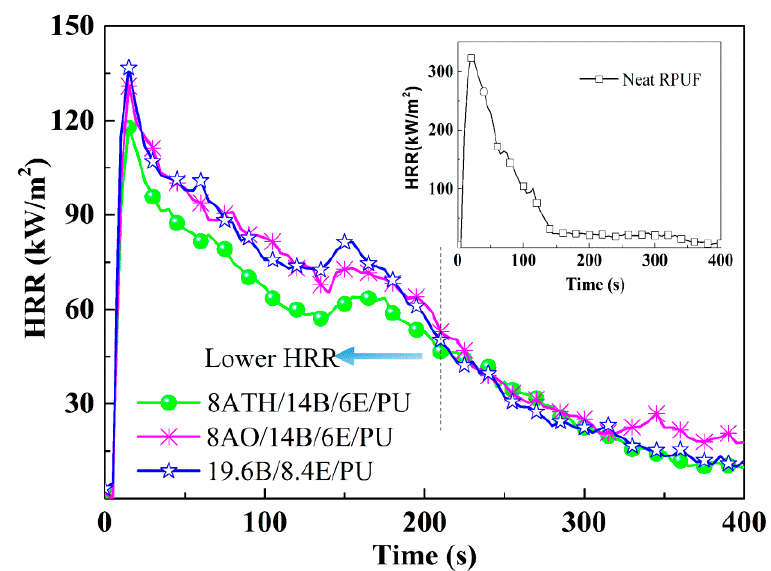
Figure 1. Heat release rate (HRR) curves of typical flame retardant rigid polyurethane foams (RPUFs).